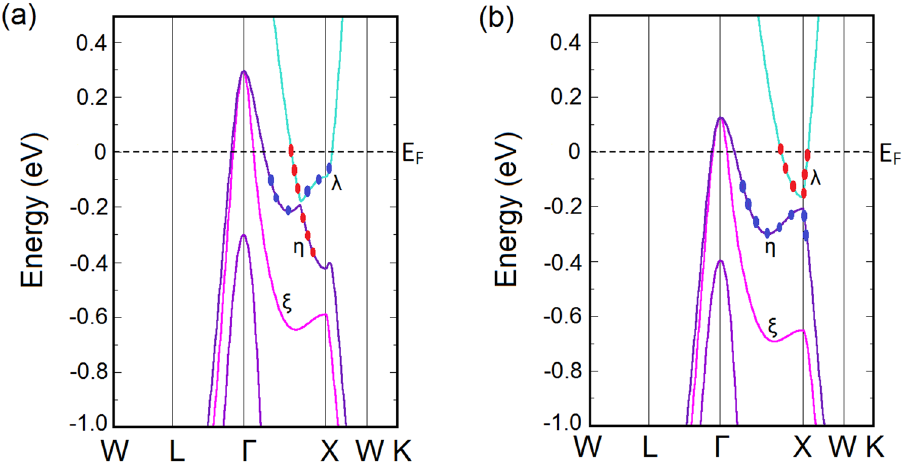
Figure 2. Calculated bulk band structures of LaSb with ( a ) LDA functional and ( b ) mBJLDA functional along the high symmetry k-path ( − − Γ − − − W L X W K ) shown in Fig. 1(b). Here, the red dots indicate the contribution of the La 5d orbitals and the blue dots show the contribution of the Sb 5p orbitals. The band inversion as indicated by the switching of the Sb-5p and La-5d orbitals between the valence and the conduction bands in ( a ) is removed by the inclusion of the mBJ potential in ( b